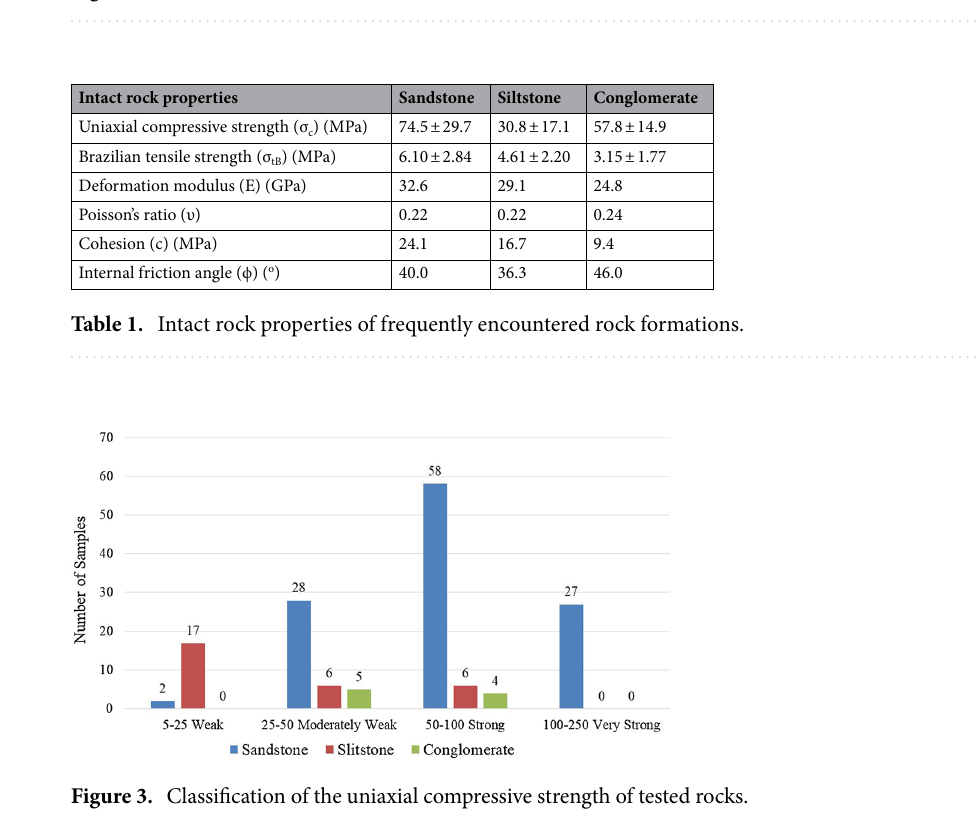
Figure 2. Observed rock formations in the coal basin.